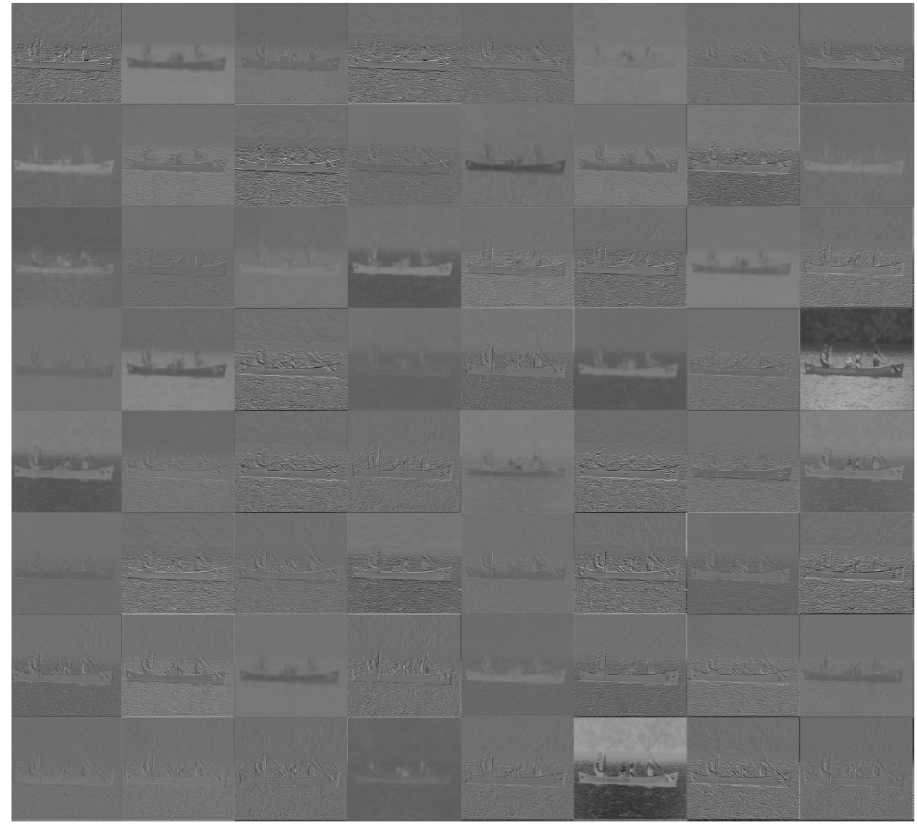
Figure 2. CNN features of the input image extracted by conv1 _ 1 of the VGG16.